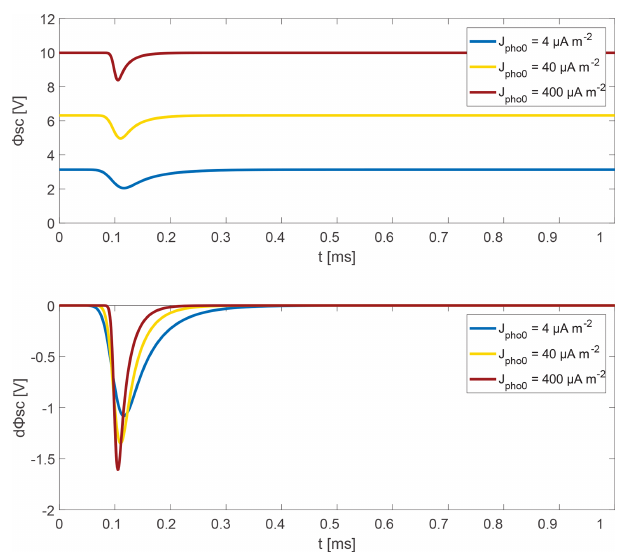
Figure 14. The spacecraft potential change during dust impact for different values of the photocurrent. A typical value of photocurrent at 1AU is 40µAm − 2 . While its influence on spacecraft potential is considerable, this is not for the change induced by